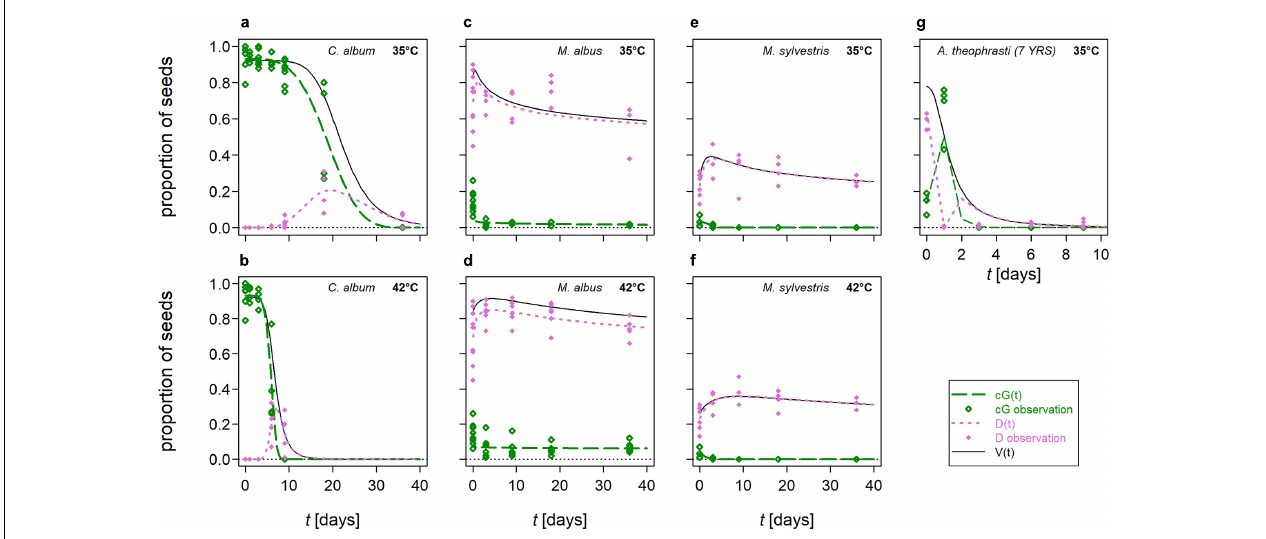
FIGURE 4 | Modeled proportions of germinated (cumulative germination, cG , green long-dashed lines) and dormant seeds ( D, pink dotted lines) out of all viable seeds ( V, black solid lines, compare Figure 3 ) of selected flowering wild plant species after mesophilic, anaerobic digestion. D(t) was calculated from the difference between the models for V(t) and cG(t) . Symbols represent observations, each based on a minimum of 100 seeds: green open diamonds for cG and pink closed diamonds for D . (a,b) Chenopodium album at 35 and 42 ◦ C, respectively; (c,d) Melilotus albus at 35 and 42 ◦ C, respectively; (e,f) Malva sylvestris at 35 and 42 ◦ C, respectively; (g) Abutilon theophrasti – 7 years at 35 ◦ C. Please note the different scaling of the x -axis in (g)